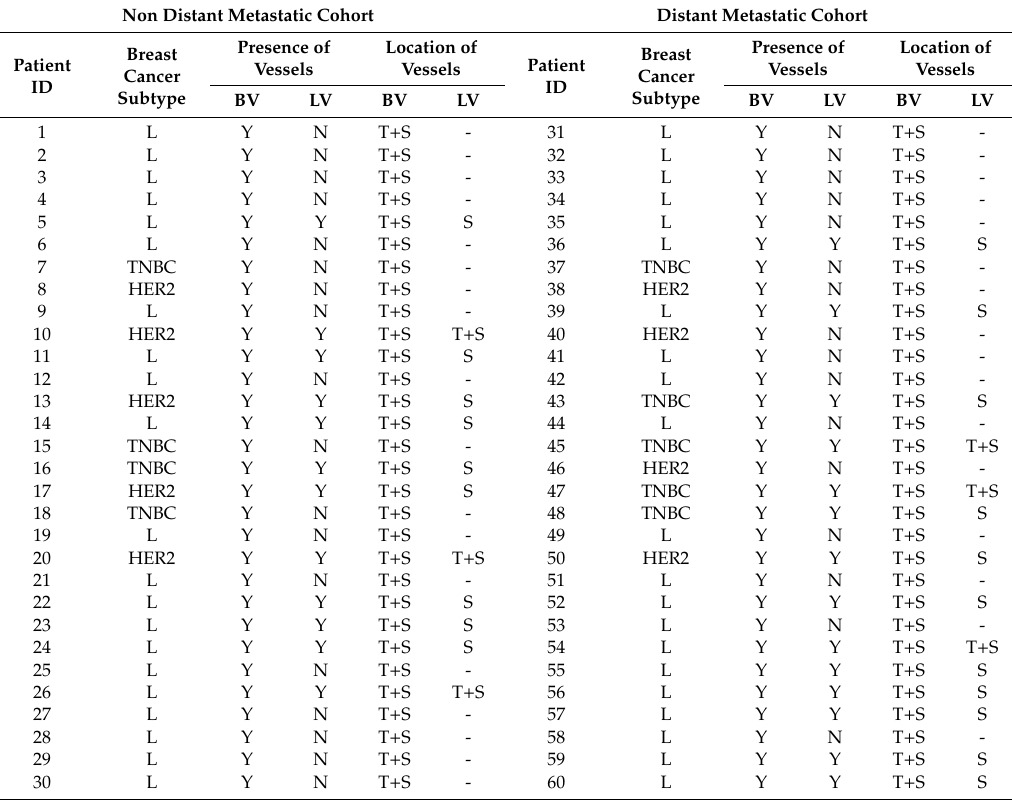
Table 2. Presence or absence of BVs and LVs, and their location with regard to tumor cell nests and tumor-associated stroma or both.